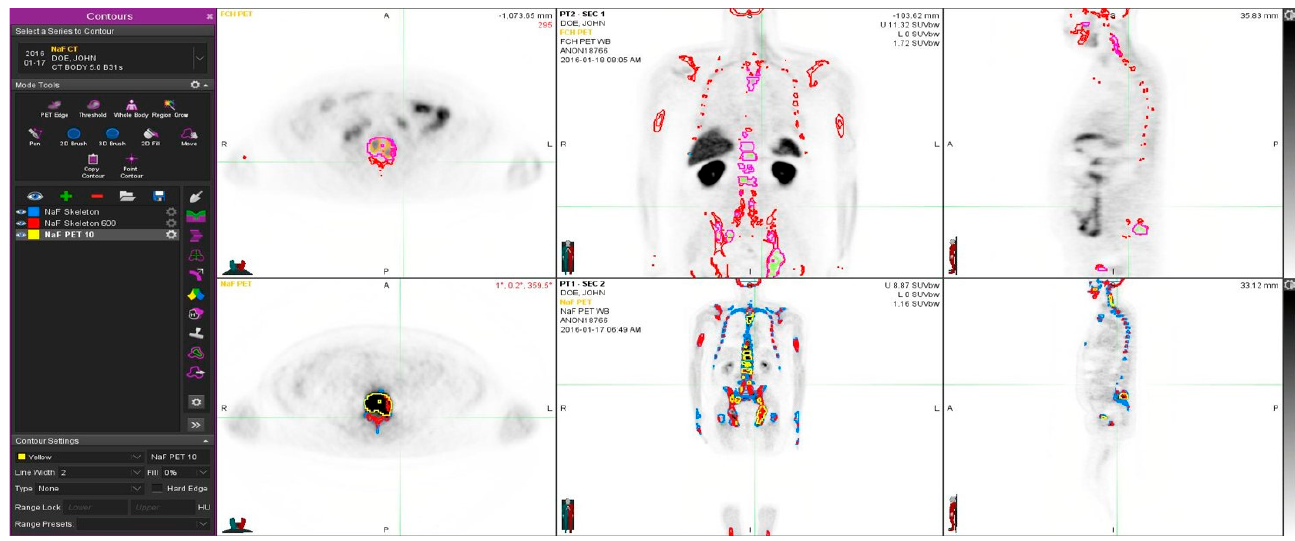
Figure 2. Example of a patient study (pt 12, Table 1). This 50-year old patient had an aggressive prostate cancer, T4N1M1 with initial PSA 700 and Gleason score 9. He was treated with radiation therapy, hormonal therapy, chemotherapy and multiple targeted bone therapies. At the time of the imagings S-PSA was 90. The upper row shows FCH PET study one transaxial, coronal and sagittal section. The lower row illustrates the same sections in the NaF PET study. Here, normal skeleton (HU > 150, as measured from simultaneous CT), is shown in blue on NaF PET (lower row). Sclerotic bone (HU > 600) is shown in red in all images. Pathologic NaF (SUV > 10) is shown in yellow (lower row) on NaF PET and in purple on FCH PET (upper row). This demonstrates clearly that volume regions differ significantly from each other, and PET tracers show different